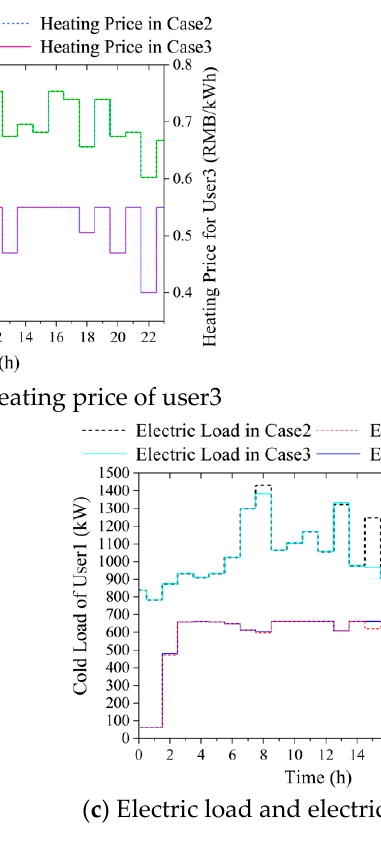
Figure 9. Strategies comparison between case2 and case3 in summer.